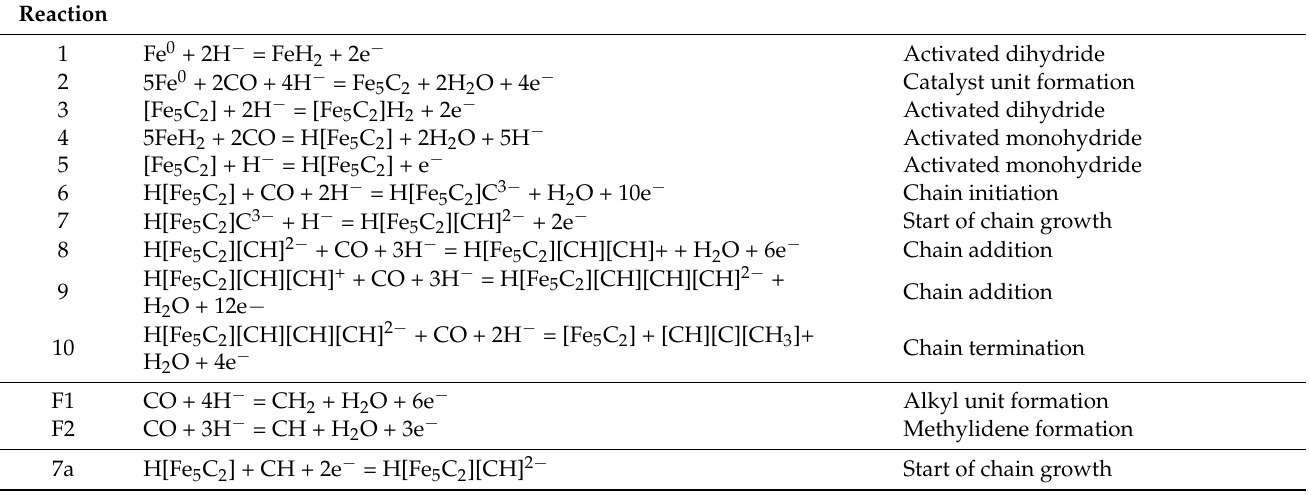
Table 16. Chain growth using an alkylidyne mechanism to produce